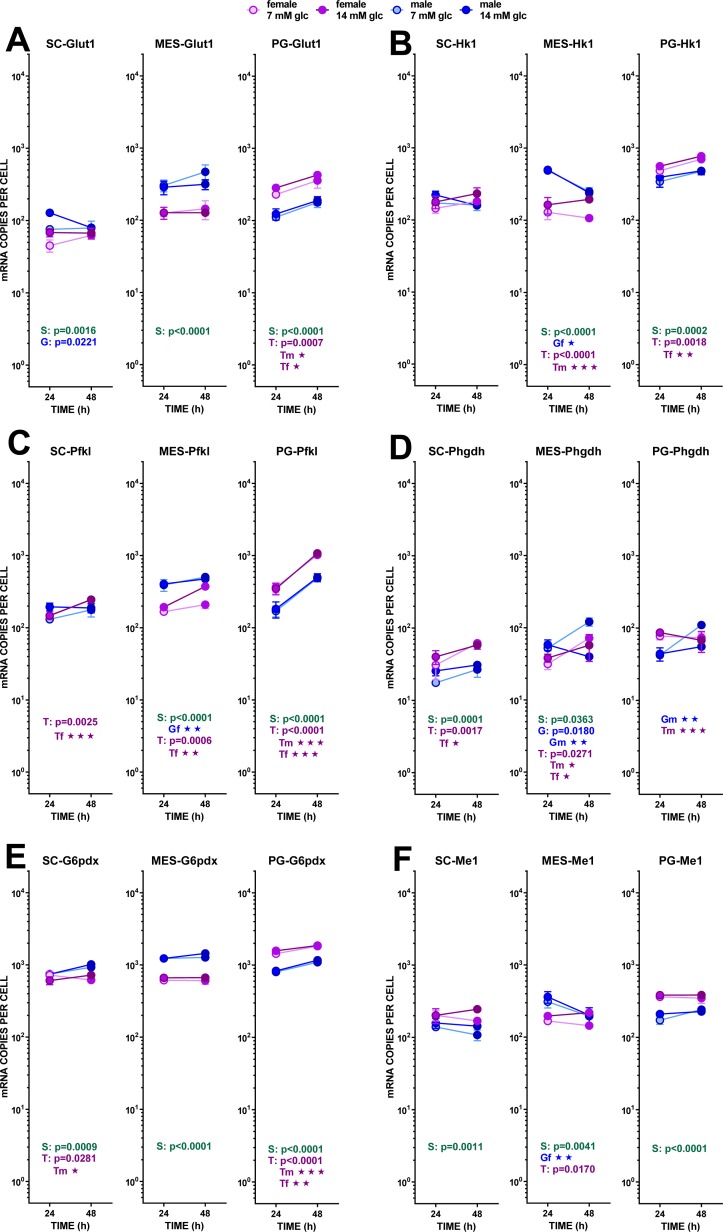
Expression of genes related with the metabolism of glucose, lipogenesis and 3C handling in adipocytes of male and female adult rats incubated in the presence of 7 mM or 14 mM glucose (I).The data are the mean ± sem of four (or three) groups of two rat-pools for sex and site, incubated for 24 or 48 h, and represent the number of mRNA copies per cell of each gene. The data are presented on a log scale. Blue circles indicate males: deep blue 14 mM glucose, light blue 7 mM glucose; purple circles represent females: violet-purple 14 mM glucose, mauve 7 mM glucose. SC, subcutaneous, MES, mesenteric and PG, perigonadal WAT. (A) Glut1, (B) Hk1, (C) Pfkl. (D) Phgdh, (E) G6pdx, (F) Me1. Statistical analysis of the differences between groups: the figures contain the p values for a three-way ANOVA analysis (sex (S in green), glucose (G in blue) and time of incubation (T in purple)) applied to each site. Results of two-way ANOVA for these paramers are also represented: the letters and colors are the same, adding m for male and f for female subgroups; for two-way ANOVAs, the p values are represented by up to three stars, corresponding to three levels of statistical significance of the differences (p < 0.05, p < 0.01 and p < 0.001). Only significant differences have been represented. The results for the four-way ANOVAs were significant (p < 0.0001) for time in all gene expressions. The effect of sex was significant only for Pfkl (p = 0.0006) and Me1 (p = 0.0007), that of glucose concentration was significant for Hk1 (p = 0.0371), Phgdh (p = 0.0164) and Me1 (p = 0.206). The effect of time of incubation was significant for Glut1 (p = 0.0023) and Pfkl, Phgdh, and G6pdx (p < 0.0001). Non-statistically significant data (p > 0.05) were not represented.